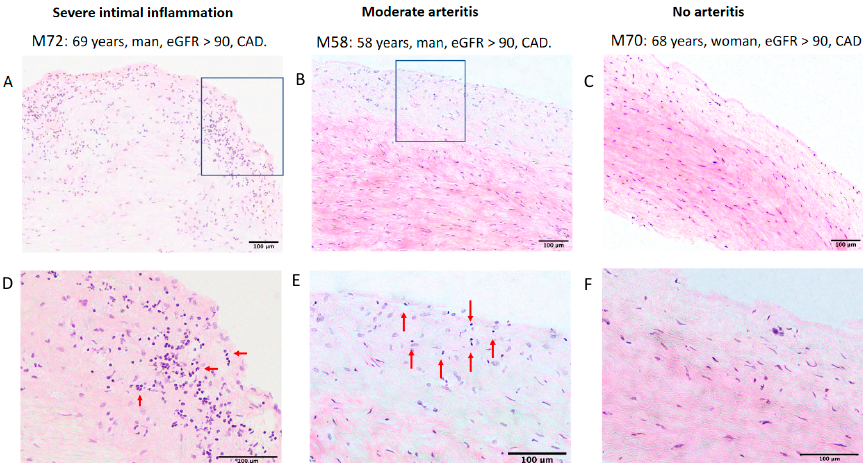
Figure 2. Severity of vascular inflammatory lesions as evaluated by a semi-quantitative scoring system based on the mononuclear infiltration of the intima. Shown are representative sample from three patients at two magnifications. Infiltrating mononuclear cells are indicated by red arrows. Frames in panels ( A–C ) represent the areas magnified in panels ( D–F ) for patients M72 and M58. For patient M70, both panels are from di ff erent areas because of the low number of infiltrating cells. The degree of inflammation was graded as “No arteritis” when < 5 cell / field were observed, “mild arteritis” when there were 5–10 cells / field, “moderate arteritis” when there were 10–20 cells / field, and “severe intimal arteritis” when there were > 20 cells / field. Bars show magnification. Abbreviations: CAD = coronary artery disease, eGFR = estimated glomerular filtration rate. Scale bar = 100 µ